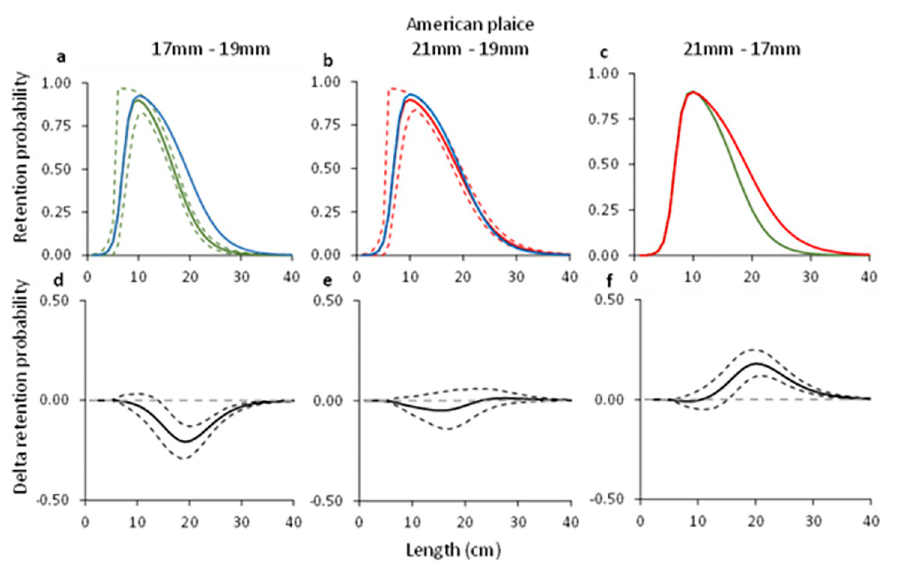
Fig 9. Combined (grid and codend) selectivity curves (a-c) and delta plots (d-f) obtained with different grid bar spacing for American plaice. In plots a-c, the green curve shows results for 17 mm, blue– 19 mm, and red– 21 mm grid spacing. Stippled lines are the 95%